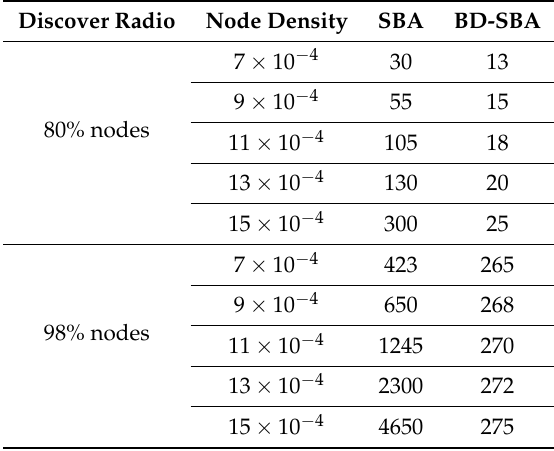
Figure 12. Performance of different node density. Table 2. Scans times of different node